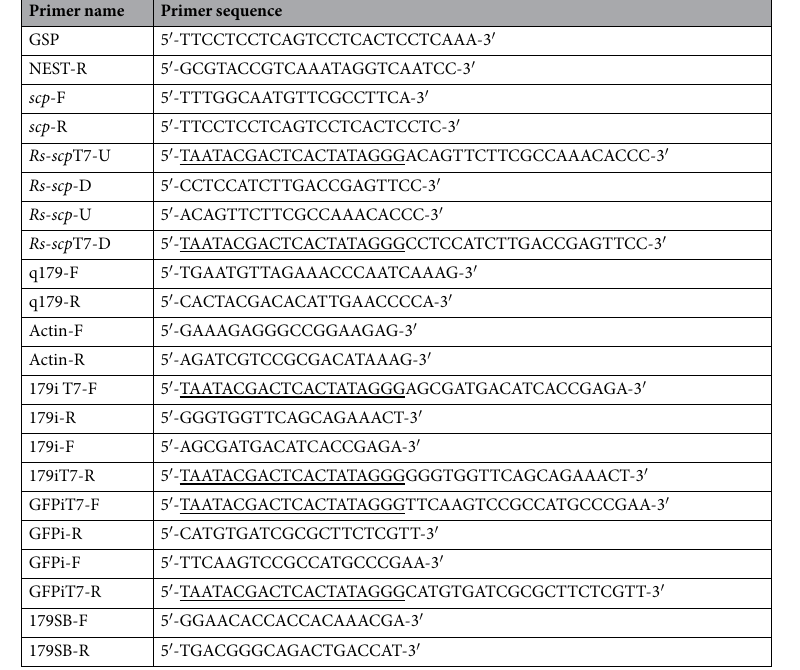
Table 1. Primer used in this study. The T7 promoter sequence is